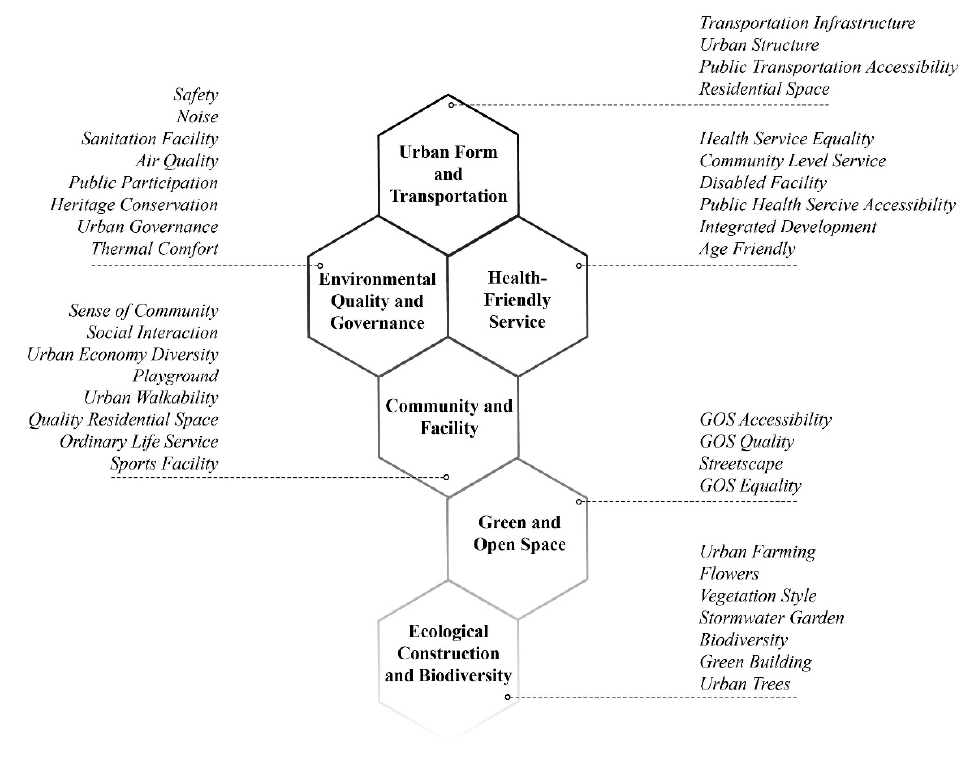
Figure 3. Spatial-health indicator framework for a Healthy City in small and midsized